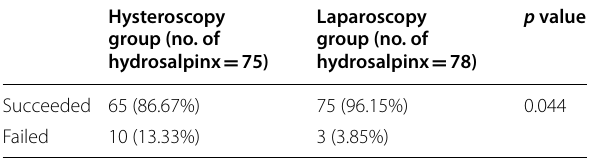
Table 2 The success rate of tubal occlusion in the studied groups a